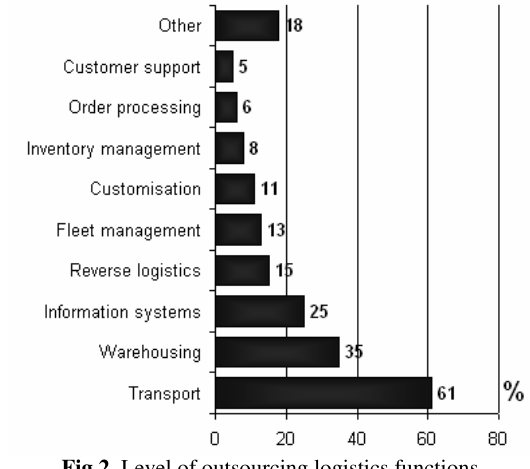
Fig 2. Level of outsourcing logistics